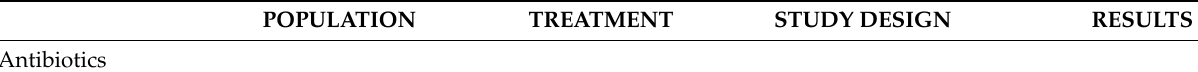
Table 1. Summary of available human studies on treatments targeting the microbiome in